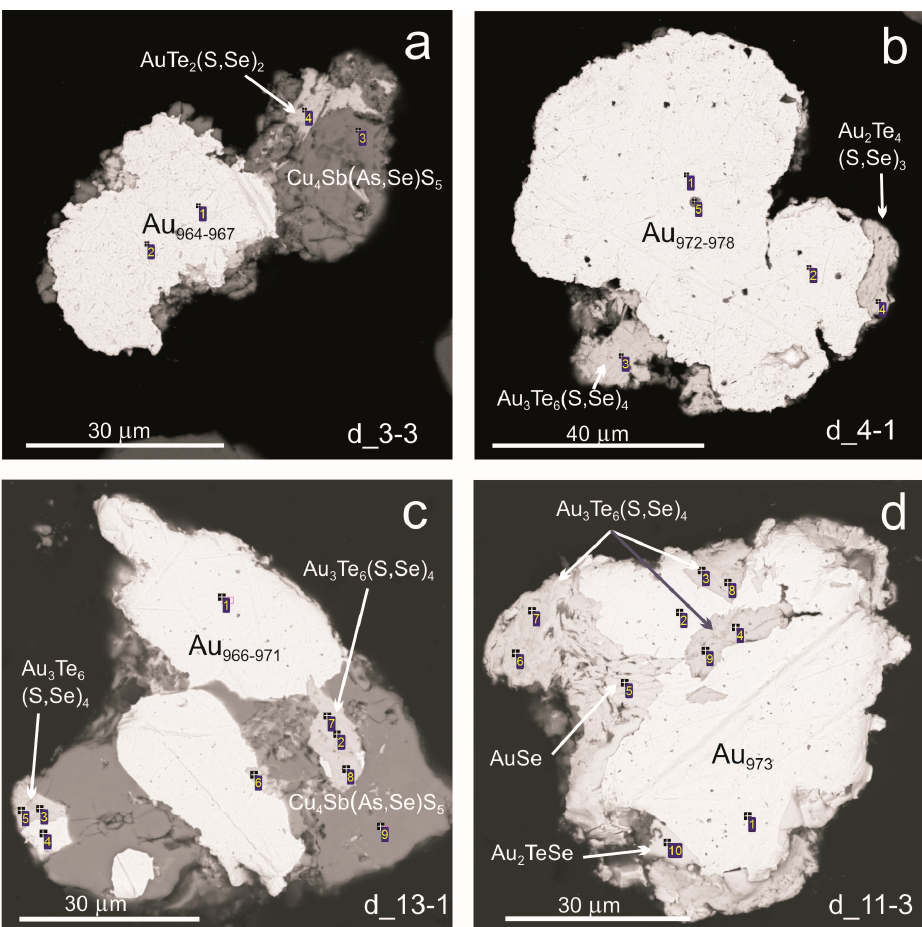
Figure 2. Secondary electron images of scanning electron microscopy (SEM). Primary gold (Au N , where N is gold fineness) intergrown with the unnamed minerals of Au–Te–Se–S system in an intergrowth with ( a )—unnamed phases Cu 4 Sb(As,Se)S 5 and AuTe 2 (S,Se) 2 ; ( b )—maletoyvayamite Au 3 Te 6 (Se,S) 4 and unnamed Au 2 Te 4 (Se,S) 3 ; ( c )—unnamed Cu 4 Sb(As,Se)S 5 and maletoyvayamite; and ( d )—maletoyvayamite and unnamed AuSe and Au 2 TeSe. Compositions of minerals and unnamed phasesshowninTable1. Thenumbersinmicrophotographsareanaliticalspots, figures.